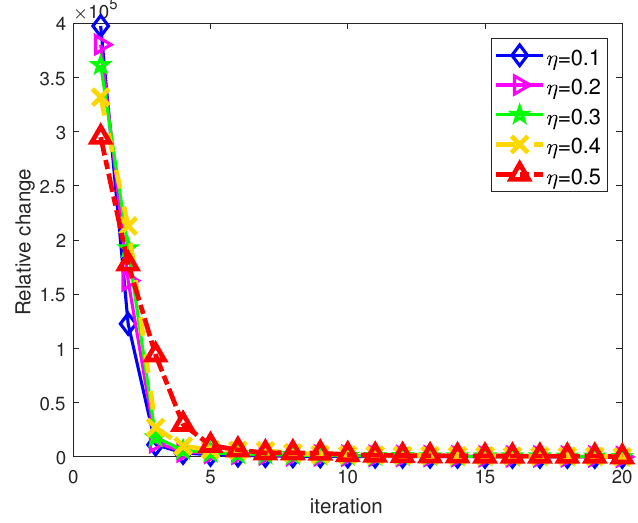
Figure 10. The convergence of the Bayes–CG